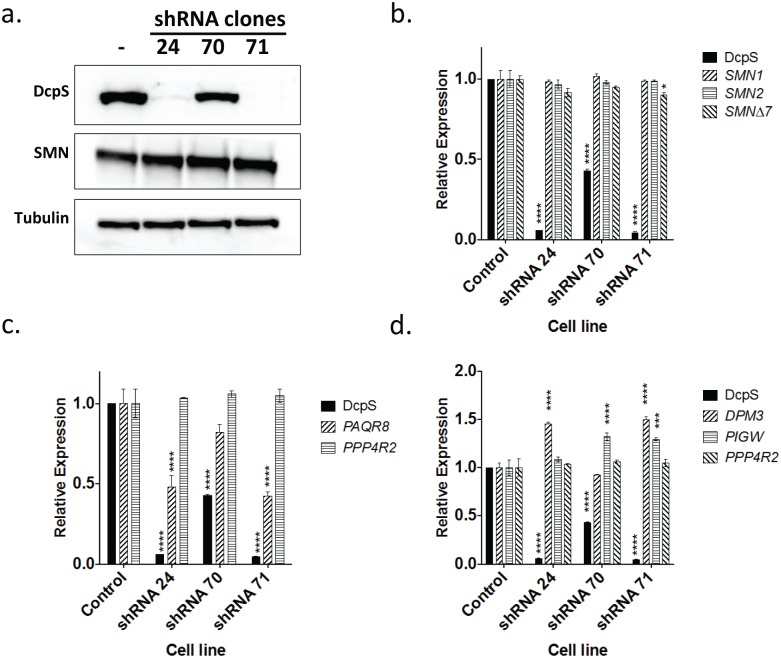
Effect of DcpS knockdown on putative DcpS-sensitive genes in stable clones of lentivirus-infected HEK-293 cells.Western blot (A) and transcript (B) analysis of DcpS lentiviral HEK293T knockdown clones. C. and D., Transcripts of putative DcpS-sensitive genes. All numerical data are shown as mean ± s.e.m. and where not shown error bars are within the size of the symbols. Levels of statistical significance were noted as P<0.05 (*), P<0.01(**), P<0.001(***), P<0.0001(****).